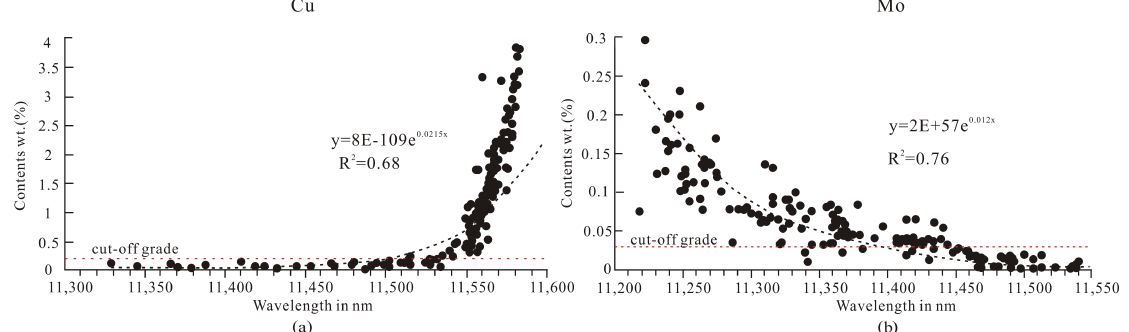
Figure 12. Correlation between garnet wavelength and content of Cu, Mo ( a , b ). The samples are from drillhole ZK024 and all drillholes with TIR on B-B’ section.